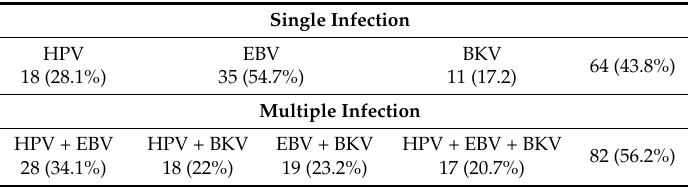
Table 2. Prevalence of human papillomavirus (HPV), Epstein–Barr virus (EBV) and BK virus (BKV) in infected